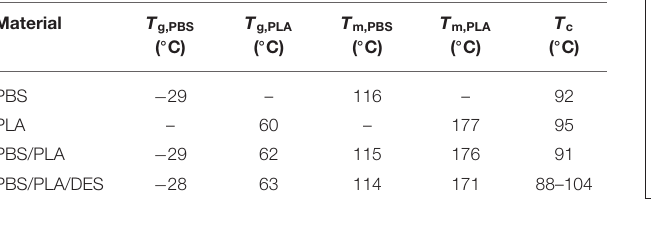
TABLE 4 | Glass transition, melting, and crystallization temperatures of poly(butylene succinate) (PBS), poly(lactic acid) (PLA), PBS/PLA (60:40 wt phr), PBS/PLA/deep eutectic solvents (DES) (60:40:1 wt phr) films determined using differential scanning calorimetry (DSC) (heating/cooling rate of 10K min − 1 under nitrogen atmosphere) before exposure.